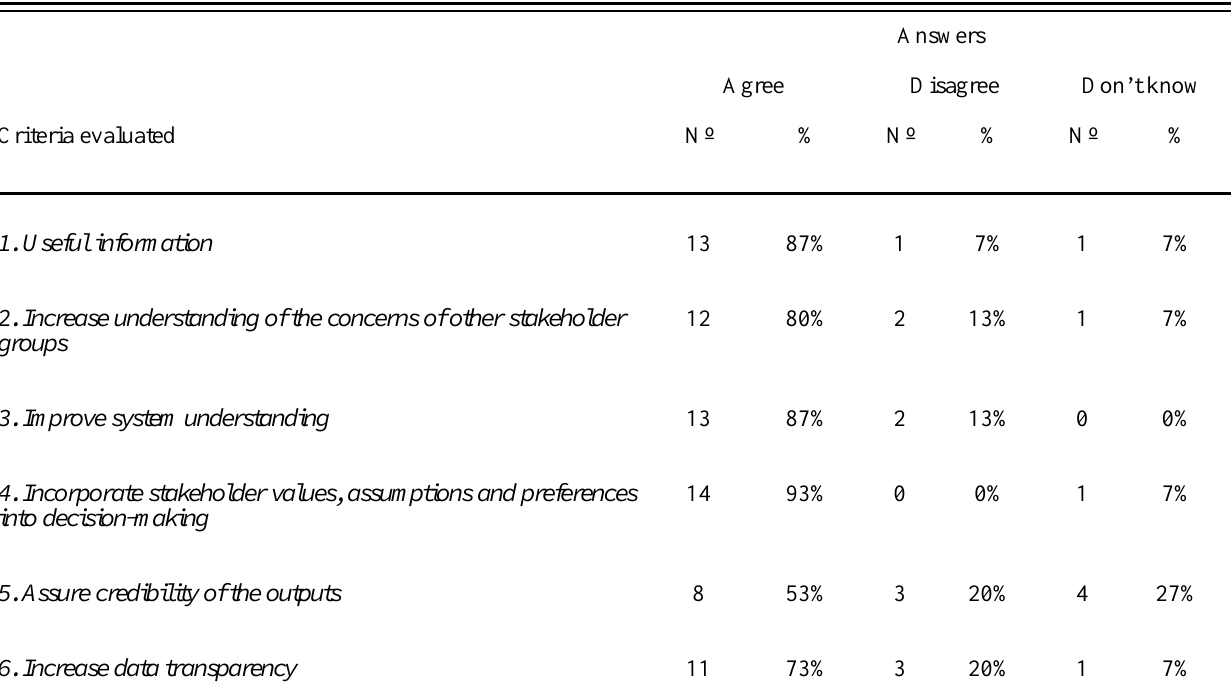
Table 5 . Questionnaire-based